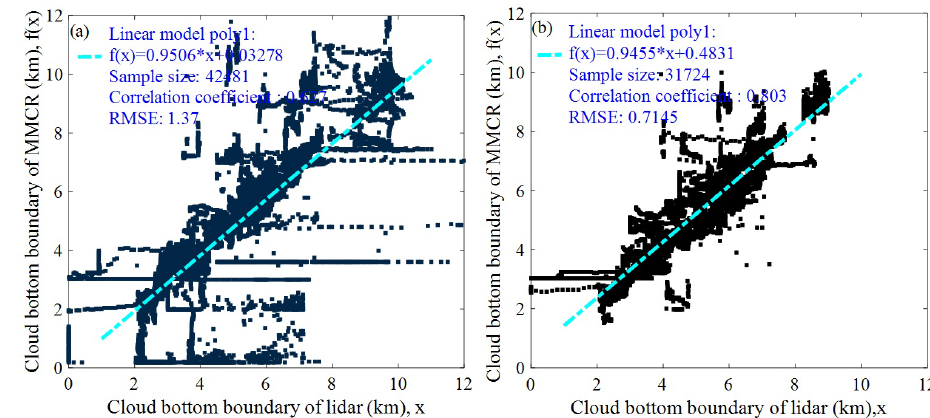
Figure 14. Correlation between lidar and MMCR cloud bottom. (a) Without quality control and (b) with quality control.